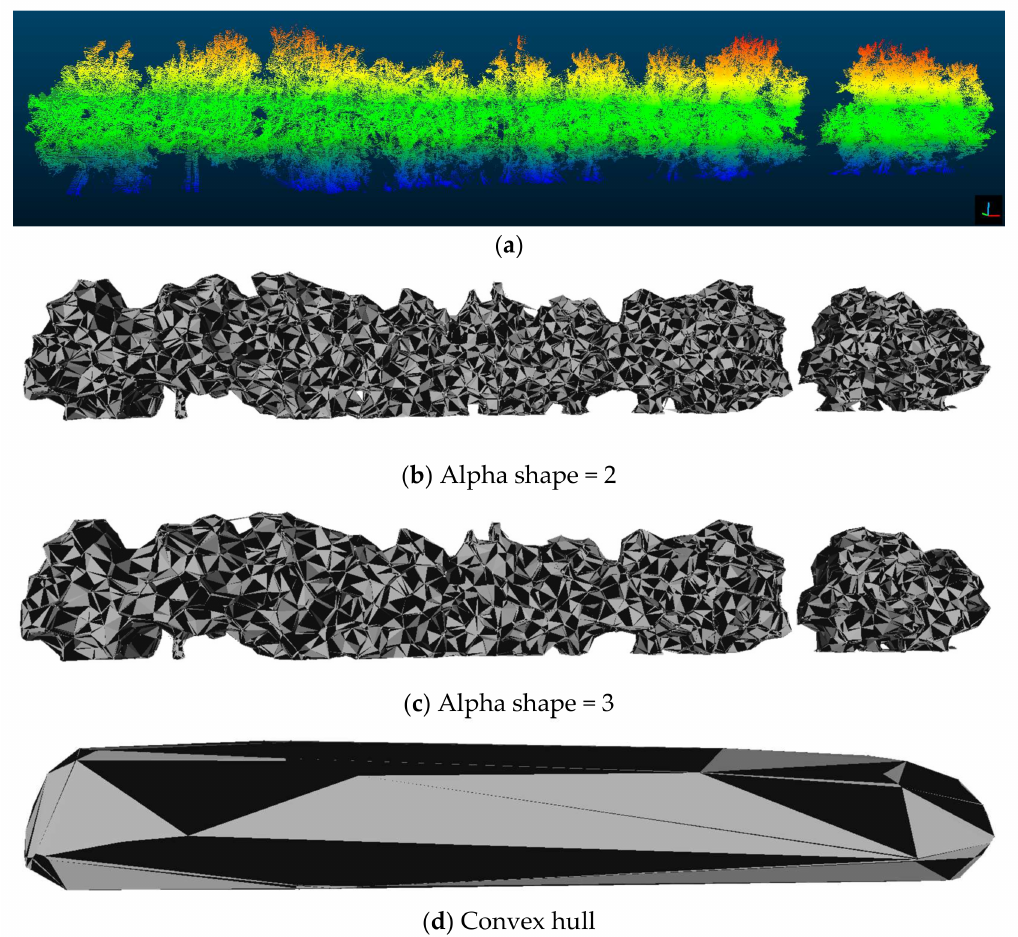
Figure 5. ( a ) A tree-row point cloud representation coloured by height; ( b ) a tree-row surface reconstruction using the α -shape algorithm with an α value = 2; ( c ) a tree-row surface reconstruction using the α -shape algorithm with an α value = 3; and ( d ) a tree-row surface reconstruction using the convex hull